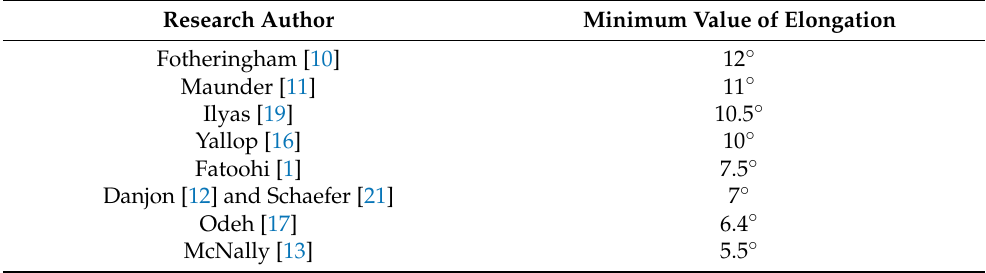
Table 1. List of the minimum values of moon elongation for early visibility according to several